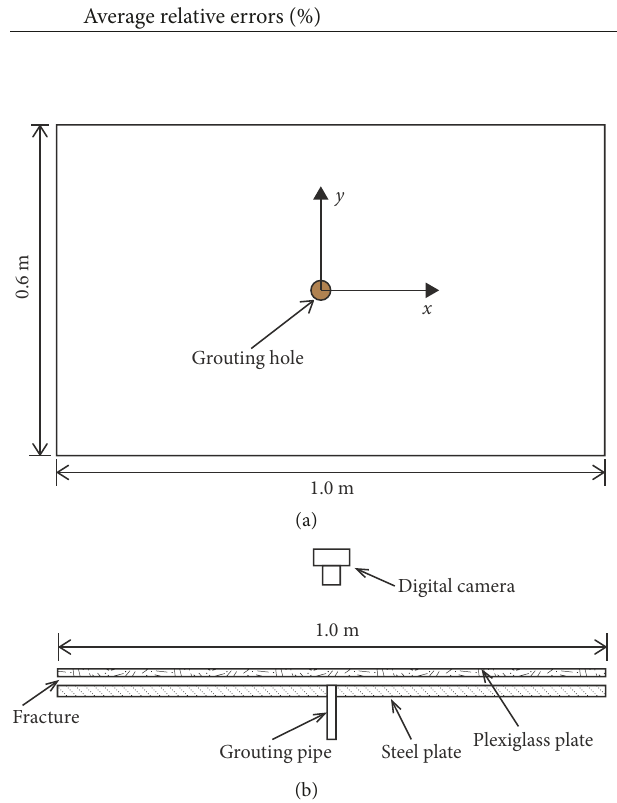
Figure 16: Schematic diagram of experimental set-up: (a) top view (b) lateral view.